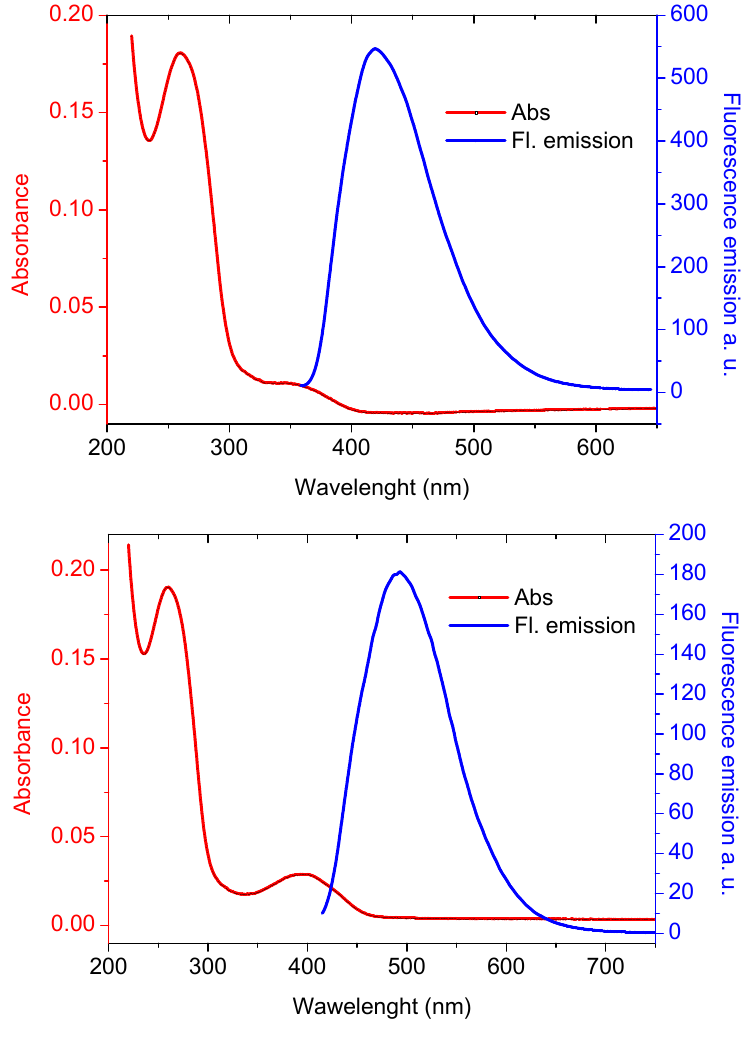
Figure 7. UV absorption (red line) and fluorescence emission (blue line) of 16-mer conjugated with Eterneon TM 350/430 azide at 1.29 μ M (top panel); and 16-mer labeled with Eterneon TM 348/480 azide (bottom panel) at 1.35 μ M concentration (unpublished